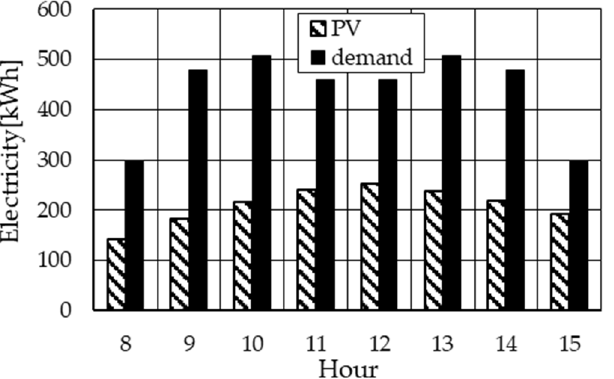
Figure 5. Electricity demand and production from PV installation.